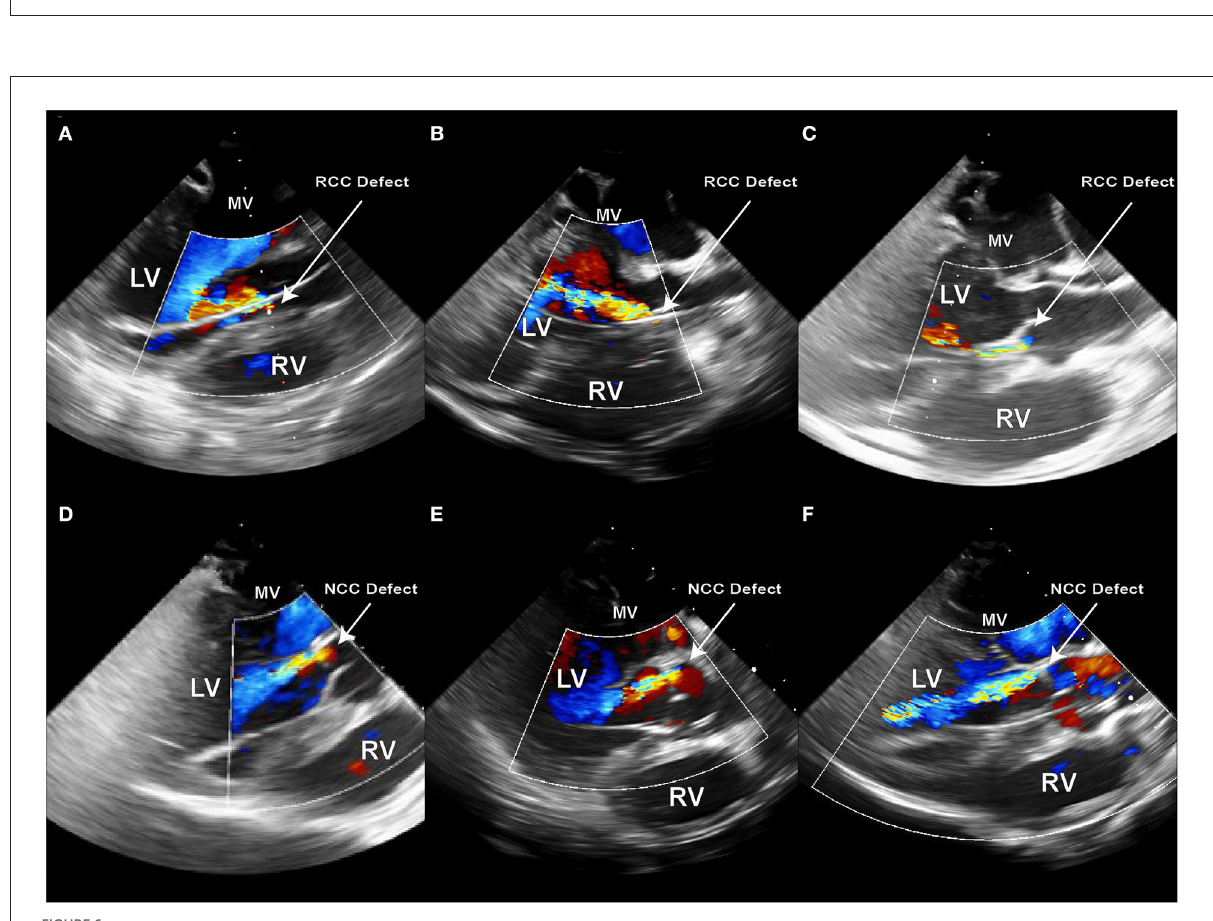
FIGURE6 Echocardiography immediately after the creation of the PVL defect in sx consecutive animals. (A–C) Defects created in the RCC annular region; (D–F) Defects created in NCC annular region; PVL jet originating from the NCC region have a trajectory along the anterior leaflet of the mitral valve and can be fully visualized along their path in the LV. RCC jets on the other hand either flow along the septum or at a steep angle across the